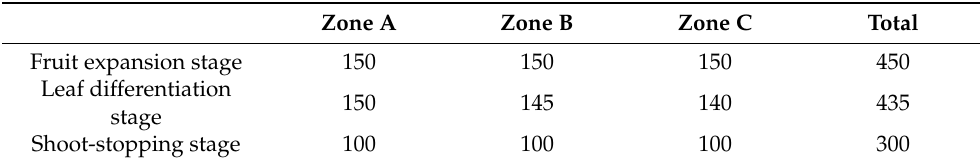
Table 6. The LAI data distribution by zones and growth stages. Zone